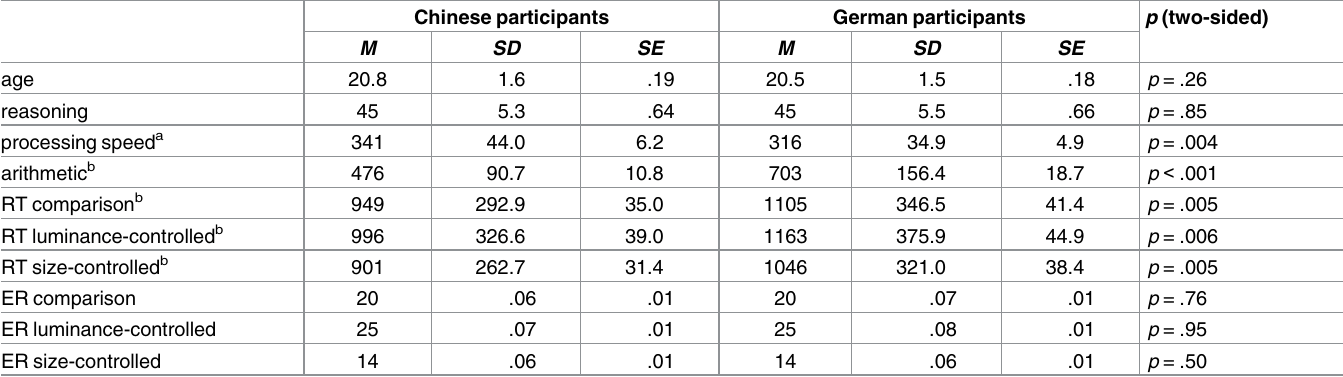
Table 2. Comparison of Chinese and German participants.